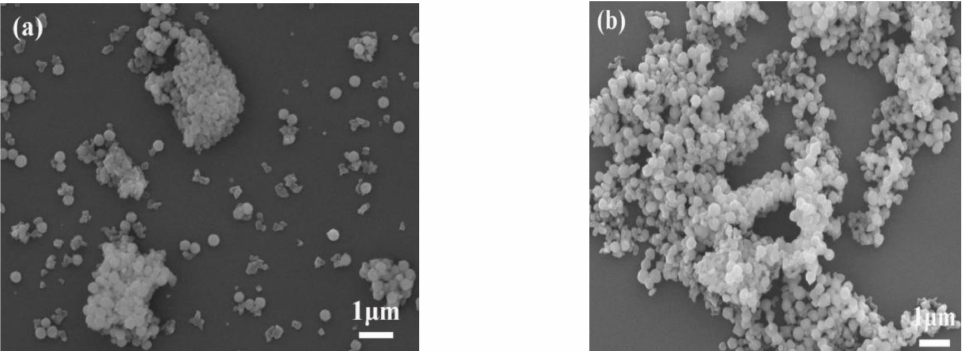
Figure 10. Micrographs showing particle morphologies of the precursor of (Y 0.94 Yb 0.06 )AG powders laying aside a month ( a ) and the precursor calcined at 1100 ◦ C ( b ).